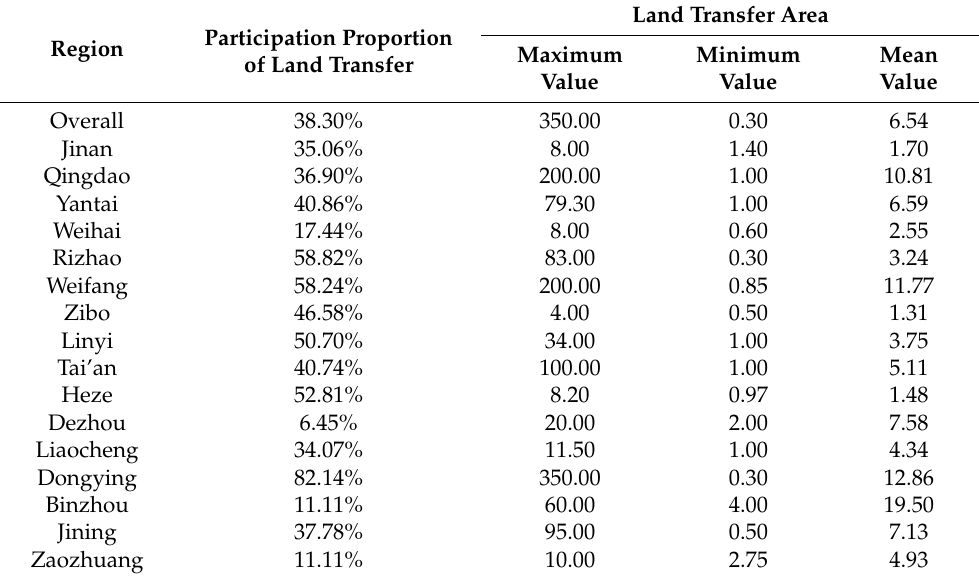
Table 2. Basic Information about the Land Transfer of Farmer